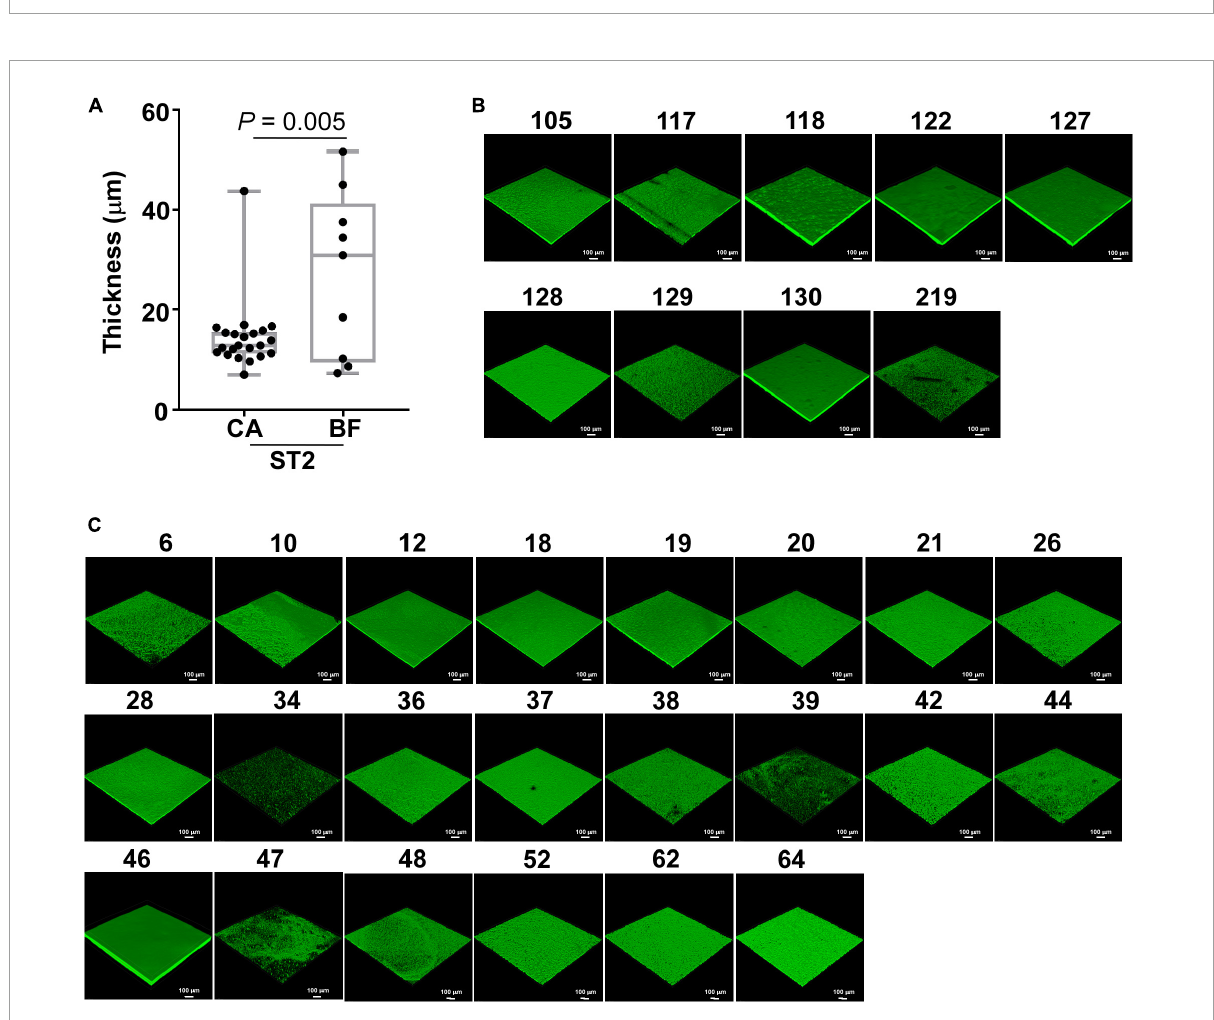
FIGURE3 Biofilm formation of Staphylococcus epidermidis ST2 strains from different infection sites. Biofilms were grown in TSB with 0.5% glucose in static condition for 48 h. After gently washing and staining, the biofilms were observed by CLSM and analyzed by Image J. (A) Thickness of biofilm. (B) Representative CLSM example pictures for ST2 strains from BF group. (C) Representative CLSM example pictures for ST2 strains from CA group. The numbers on the pictures indicated the NO of clinical strains ( Supplementary Table 1 ). The statistical significance was measured by unpaired, two-tailed t -test. Error bars show the mean ±